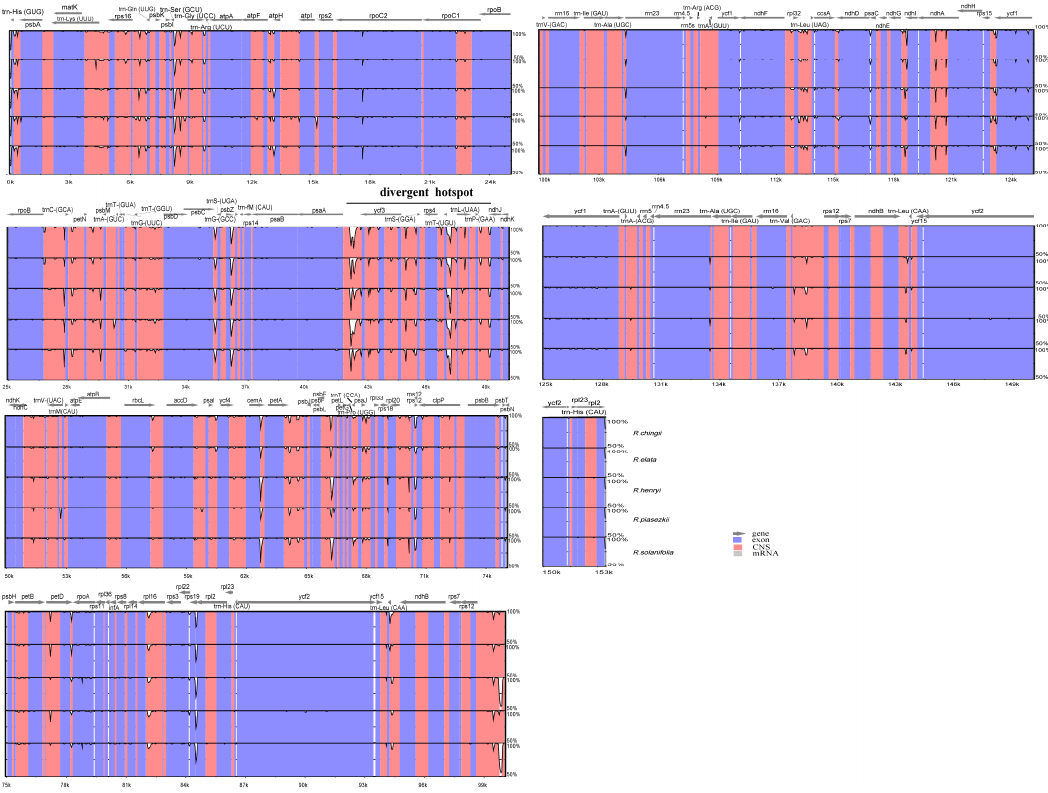
Figure 4. Visualization of alignment of the six Rehmannia species chloroplast genome sequences. VISTA ‐ based identity plots showed sequence identity of six sequenced chloroplast genomes with R. glutinosa as a reference. The sequence similarity of the aligned regions is shown as horizontal bars indicating the average percent identity between 50% and 100% (shown on the y ‐ axis of the graph). The x ‐ axis represents the coordinate in the chloroplast genome. The divergent hotspot region is indicated in the chloroplast genome. Genome regions are color coded as protein coding, rRNA coding, tRNA coding or conserved noncoding sequences (CNS).